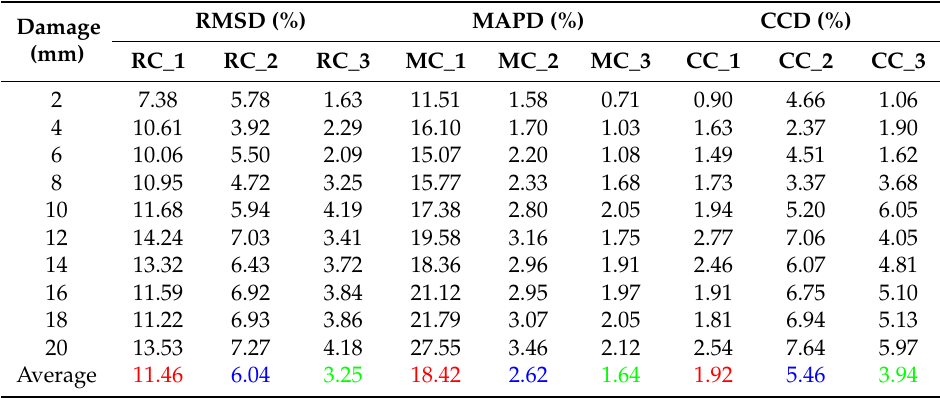
Table 1. Three statistical metric values for C_1, C_2 and C_3 experiment.